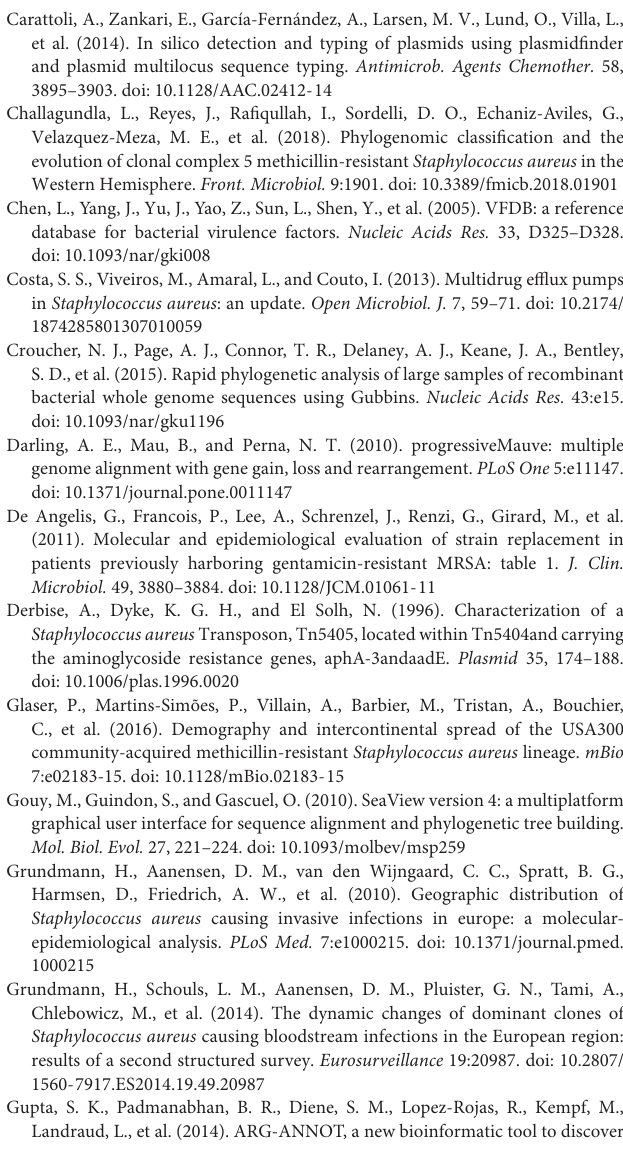
TABLE S1 | Metadata of the 530 MRSA isolates included in this study. TABLE S2 | Gubbins results representing detected genes with a high number of SNPs. TABLE S3 | Resistance and virulence factors detected in the 530 MRSA genomes. TABLE S4 | Marginal likelihood estimation for the 245 MRSA genomes sub-sampled dataset under various coalescent priors using path sampling and stepping stone. TABLE S5 | Mobile genetic elements and repetitive regions identified in the reference genome